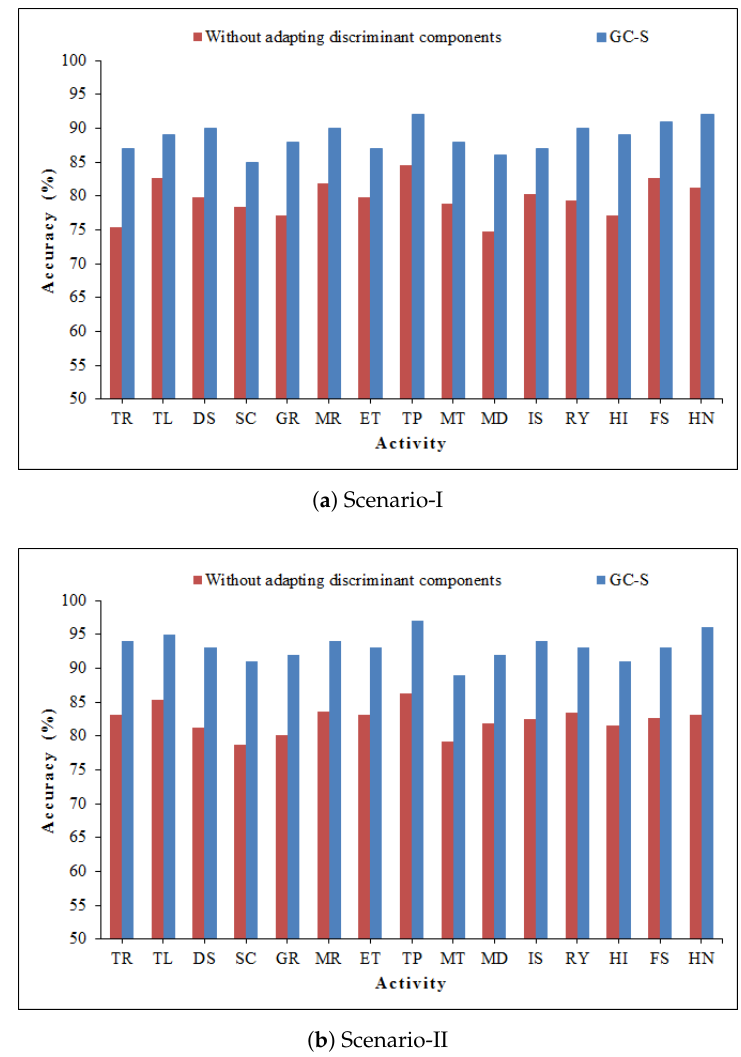
Figure 13. Comparison of accuracy without adapting discriminant component selection